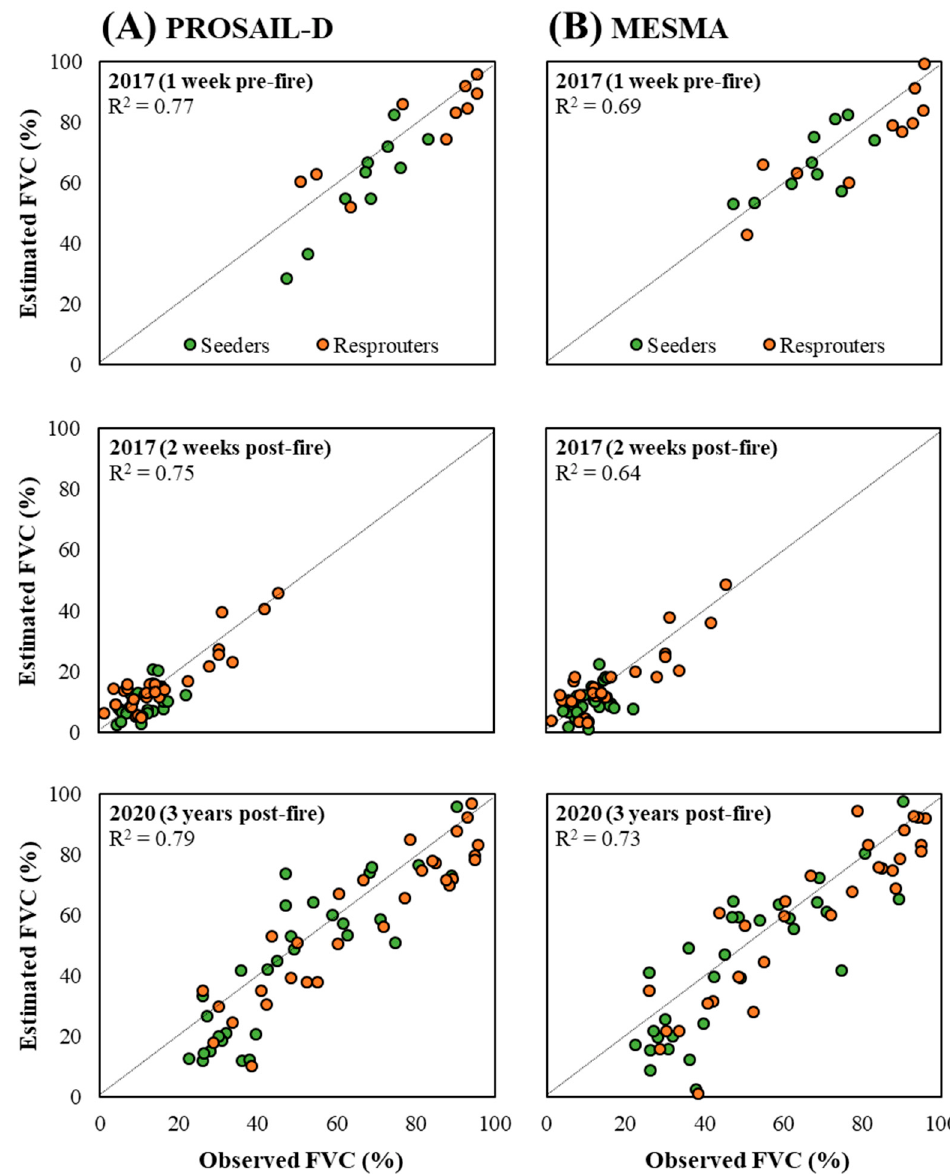
Figure 2. Relationship between the FVC measured in the field and that retrieved from Sentinel-2 imagery for the time series using PROSAIL-D ( A ) and MESMA ( B ) models.